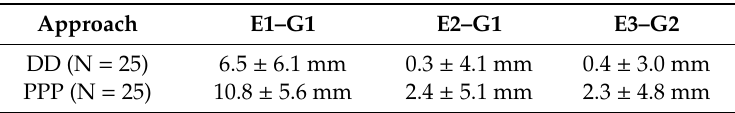
Table 5. Mean di ff erences and standard deviations in the up component between the compared solutions for the 25 stations